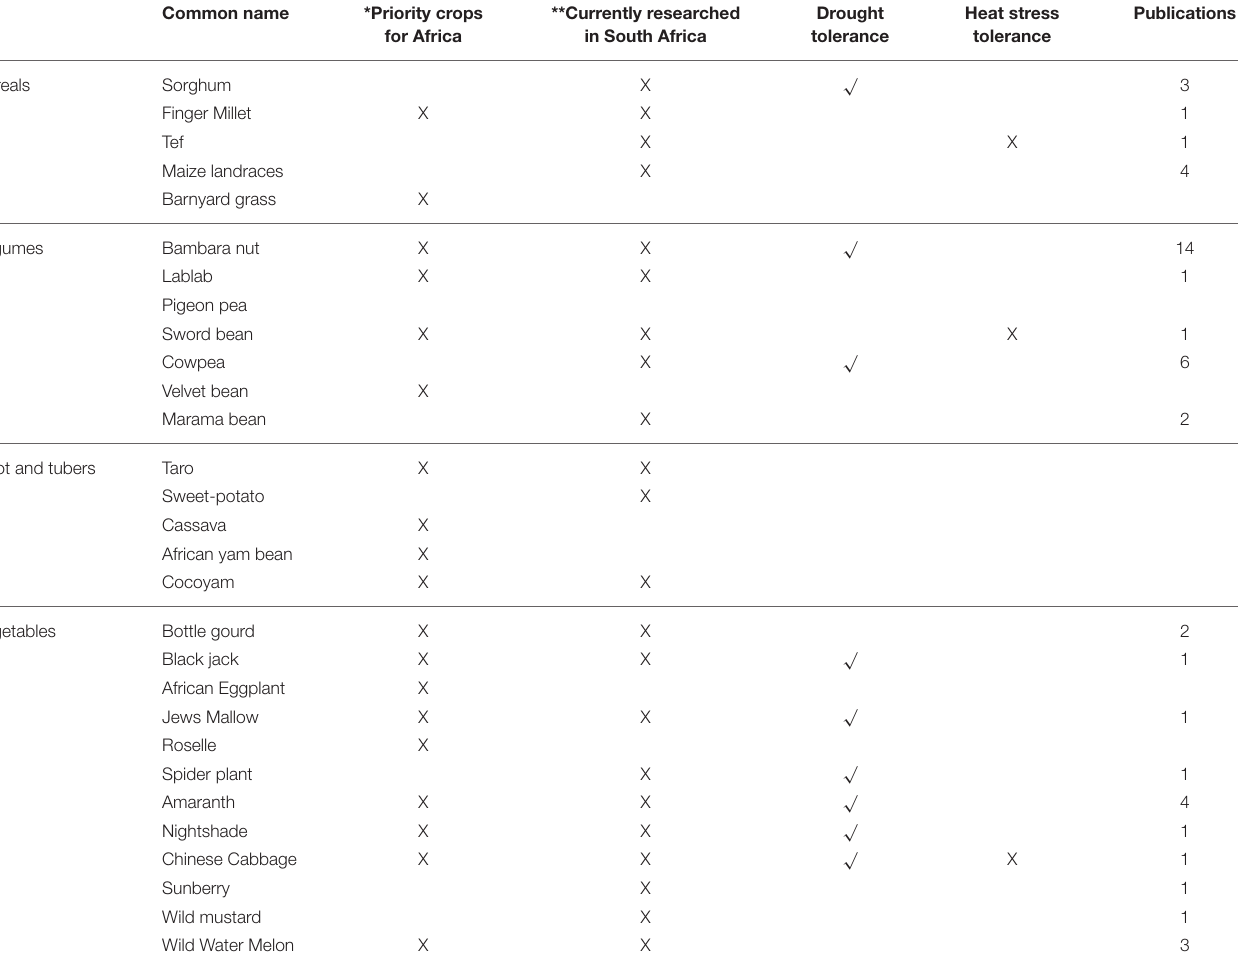
TABLE 2 | A comparison of crops listed as priority underutilized crops for Africa by Williams and Haq (2000) and the list of underutilized crops currently researched in South